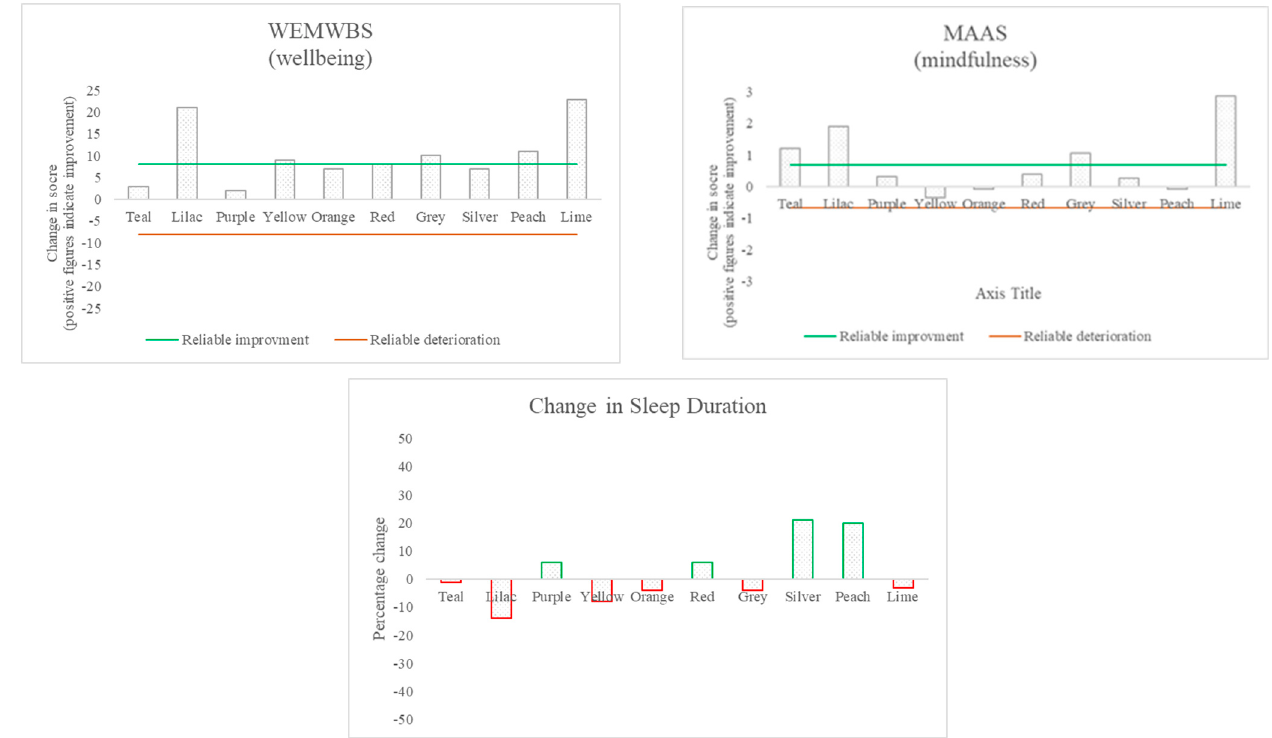
Figure 3. Changes in wellbeing and related constructs: the difference between pre- and post-measurement for each participant.